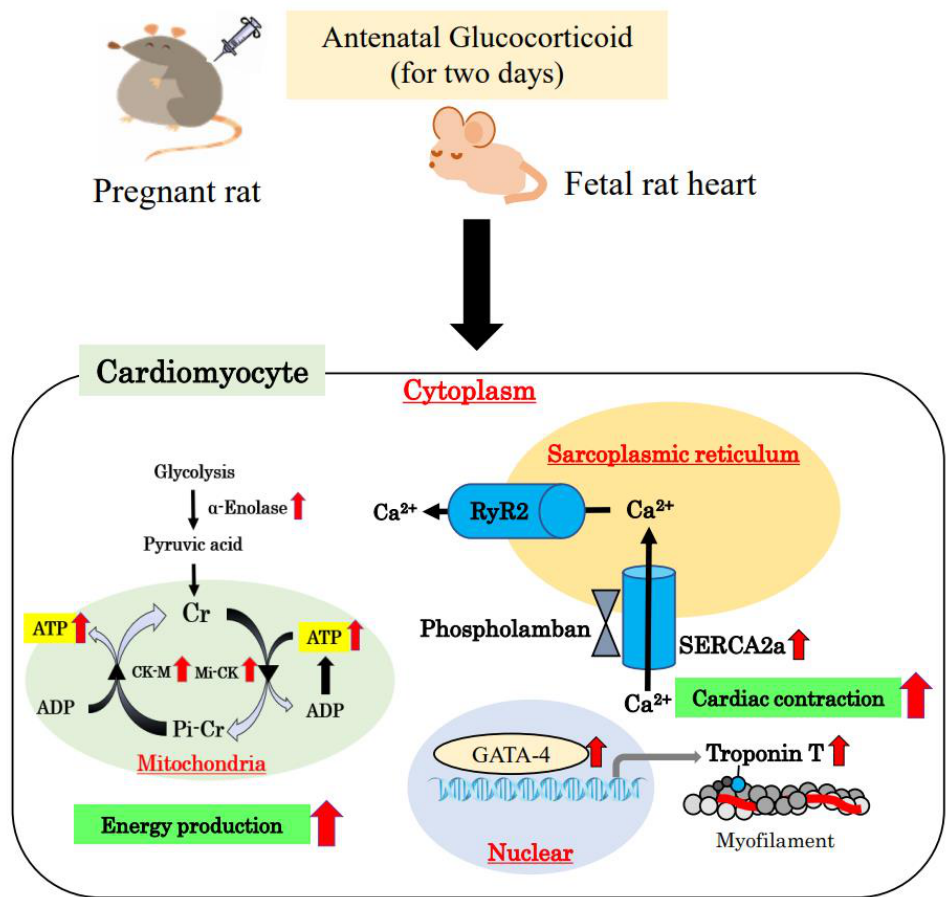
Figure 2. Schematic diagram of energy production and acceleration of cardiac contraction. Energy metabolism in the fetal heart is relatively dependent on anaerobic glycolysis. α -Enolase converts glucose into pyruvate. Energy released during glycolysis is used to make ATP, and antenatal glucocorticoid (GC) administration accelerates these pathways. Furthermore, antenatal GC administration induces creatine kinase (CK) protein production by promoting myofibrillar-bound M isoenzyme CK (CK-M) and mitochondrial CK (Mi-CK) gene expression in the mitochondria. Increased CK-M and Mi-CK enzymes contribute to increased ATP synthesis. Cardiac energy metabolism is essential for normal cardiac contractile function. GATA-4 has not only involvement in cell proliferation but also in binding the cells to the troponin T promoter. Antenatal GC increases the expression of GATA-4, troponin T, SERCA2a, and phospholamban. Cardiac contraction is increased with the increase in intracellular Ca 2+ concentration and troponin T expression. SERCA2a plays a crucial role in the regulation of the intracellular Ca 2+ concentration in the SR. Ca 2+ enters myocytes during an action potential through voltage-gated Ca 2+ channels in the sarcolemma. This Ca 2+ influx triggers the release of Ca 2+ from the SR by RyR2, which increases the intracellular Ca 2+ concentration, resulting in myocardial contraction. Sarco-endoplasmic reticulum Ca-ATPase, SERCA; sarcoendoplasmic reticulum, SR; ryanodine receptor,